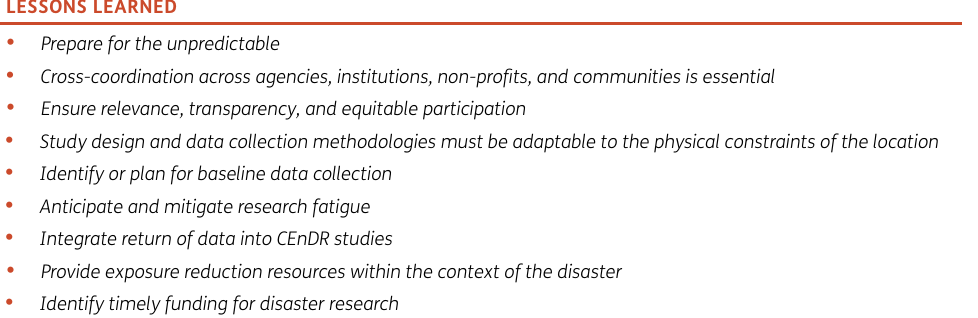
Table 3 Lessons learned following review of challenges and mitigations specific to the three case studies. Community-engaged disaster research: